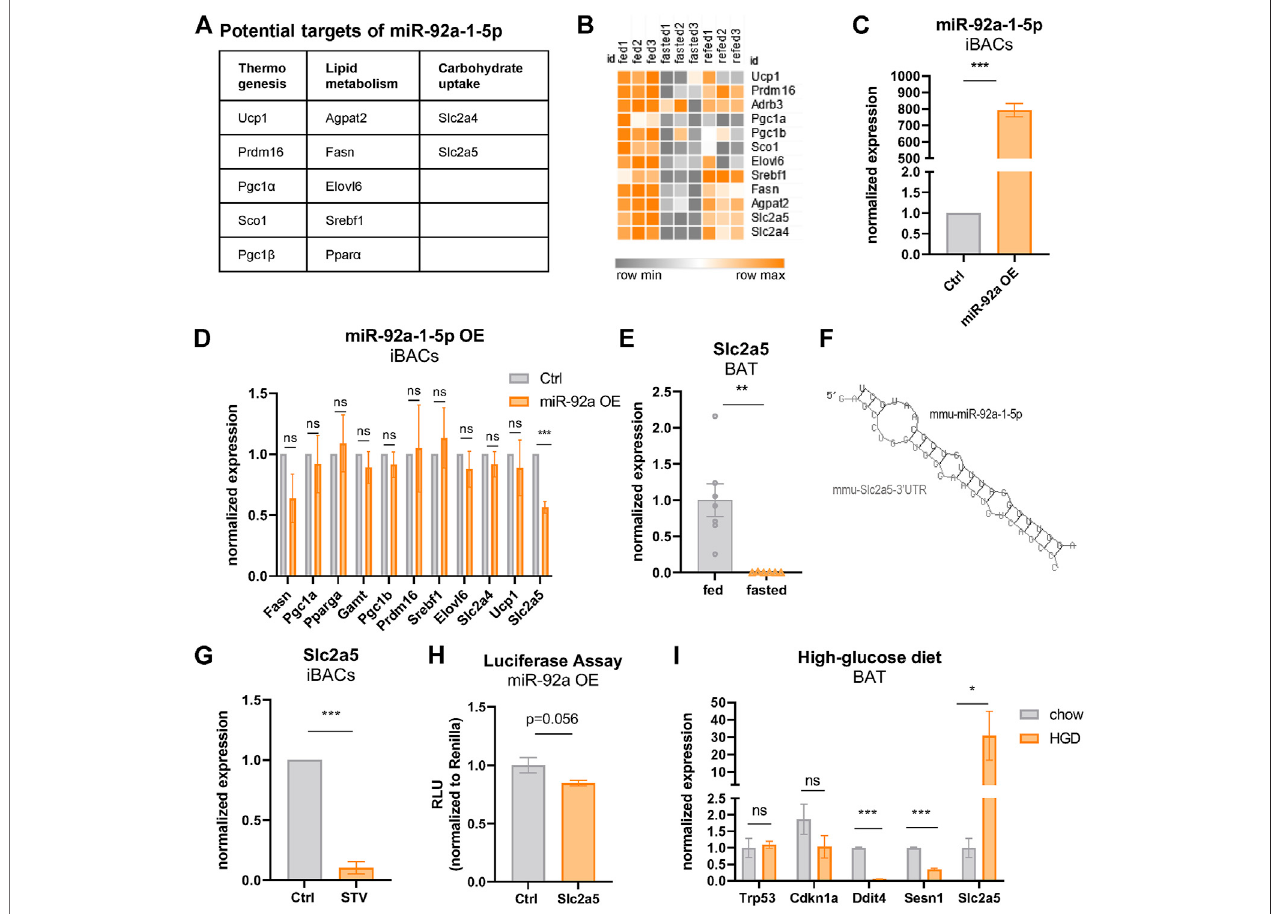
FIGURE 4 | Fasting-induced miR-92a-1-5p downregulates the fructose transporter Slc2a5 in brown adipocytes. (A) Predicted target genes of miR-92a-1-5p downregulatedbyfastinginBAT. (B) Heatmapofpredicted,fasting-downregulatedmiR-92a-1-5ptargetsinBATofctrl,24 hfasted,andrefedmice. (C) qPCRexpressionlevelsof miR-92a-1-5p in iBACs after transfection with miRNA-mimic-92a-1-5p or non-targeting control. (D) mRNA expression of predicted target genes of miR92a-1-5p in iBACs after transfectionofmiR-mimc-92a-1-5pornon-targetingcontrol. (E) mRNAexpressionof Slc2a5 inBAToffedor24 hfastedmice. (F) PutativemiRNAseedmatchofmiR-92a- 1-5p within the 3 ’ UTR of Slc2a5 . (G) mRNA expression of Slc2a5 in iBACs cultured in standard growth medium or starved for 24 h. (H) Luciferase assay was performed by co- transfectingareportervectorcontainingthe3 ’ UTRof Slc2a5 harboringthepredictedbindingsitesofmiR-92a-1-5p,withmiR-92a-1-5pmimicornon-targetingcontrolinHEK293 cells. (I) mRNA expression of Slc2a5 and p53 target genes in BAT of mice fed chow or high-glucose diet. Mean values ± SEM are shown, signi fi cant differences in the mRNA expression of fed and fasted mice were analyzed by performing an unpaired t-test. For in vitro data, unpaired t-test was performed. Differences not indicated with asterisks or indicated with ns are not statistically signi fi cant ( p > 0.05). *** p < 0.001, ** p < 0.01, and * p <